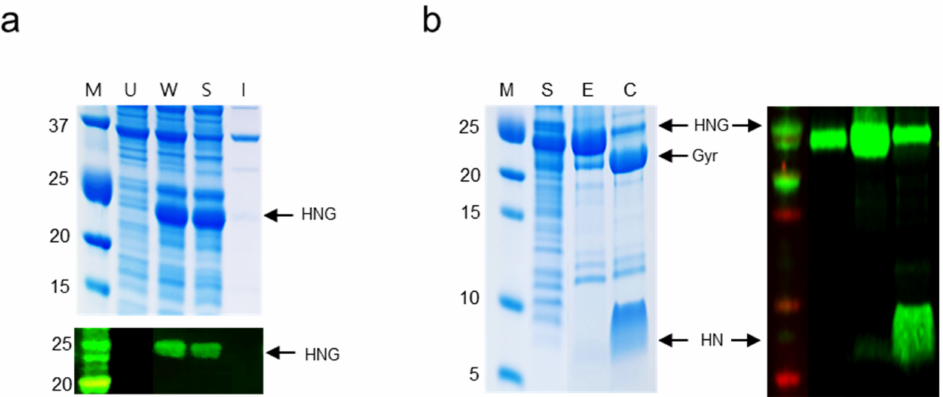
Figure 2. Expression of the His-NKC-GyrA (HNG) fusion protein. ( a ) SDS-PAGE and Western blot analyses (anti-His) of HNG expression. Lane M: protein molecular weight marker; Lane U: uninduced E. coli lysate; Lane W: whole cell lysate; Lane S: soluble fraction; Lane I: insoluble fraction. The target protein is indicated by arrows. ( b ) Analysis of purification of the HNG protein and cleavage activity of GyrA intein. Lane M: protein molecular weight marker; Lane S: soluble fraction; Lane E: elution fraction with 250 mM imidazole; Lane C: product of intein cleavage induced by MESNA. Gyr and HN indicate GyrA intein and His-NKC-thioester, respectively. The green bands on the black background represent the results of Western blot